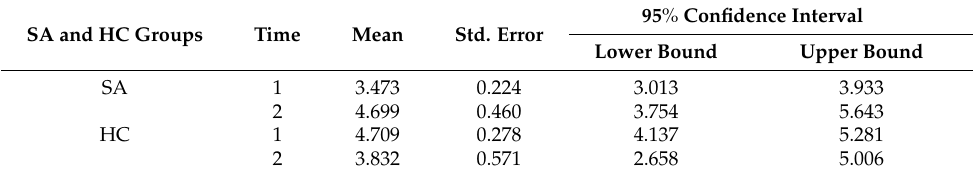
Table 11. SA and HC Groups x Time.